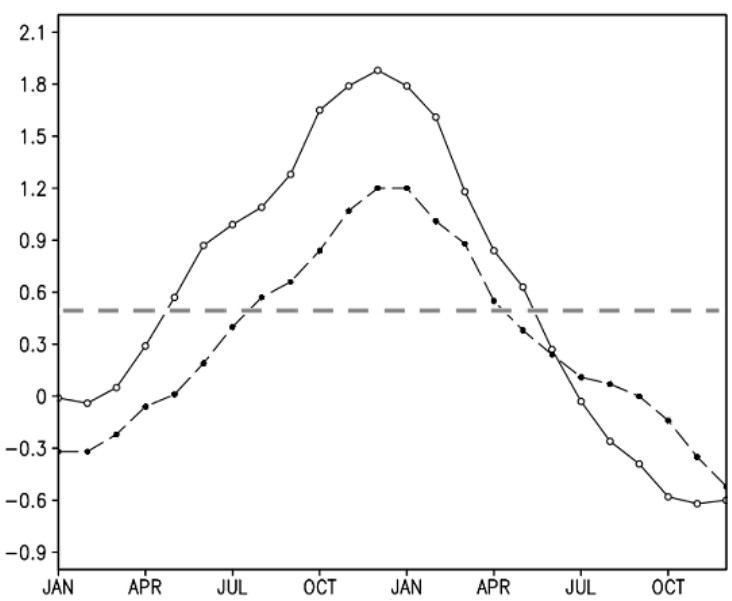
Figure 1. Composite time series of SST anomalies in the Niño 3.4 region (unit: °C) for austral autumn (open circles) and winter (solid circles) El Niño events during 1956–2017.